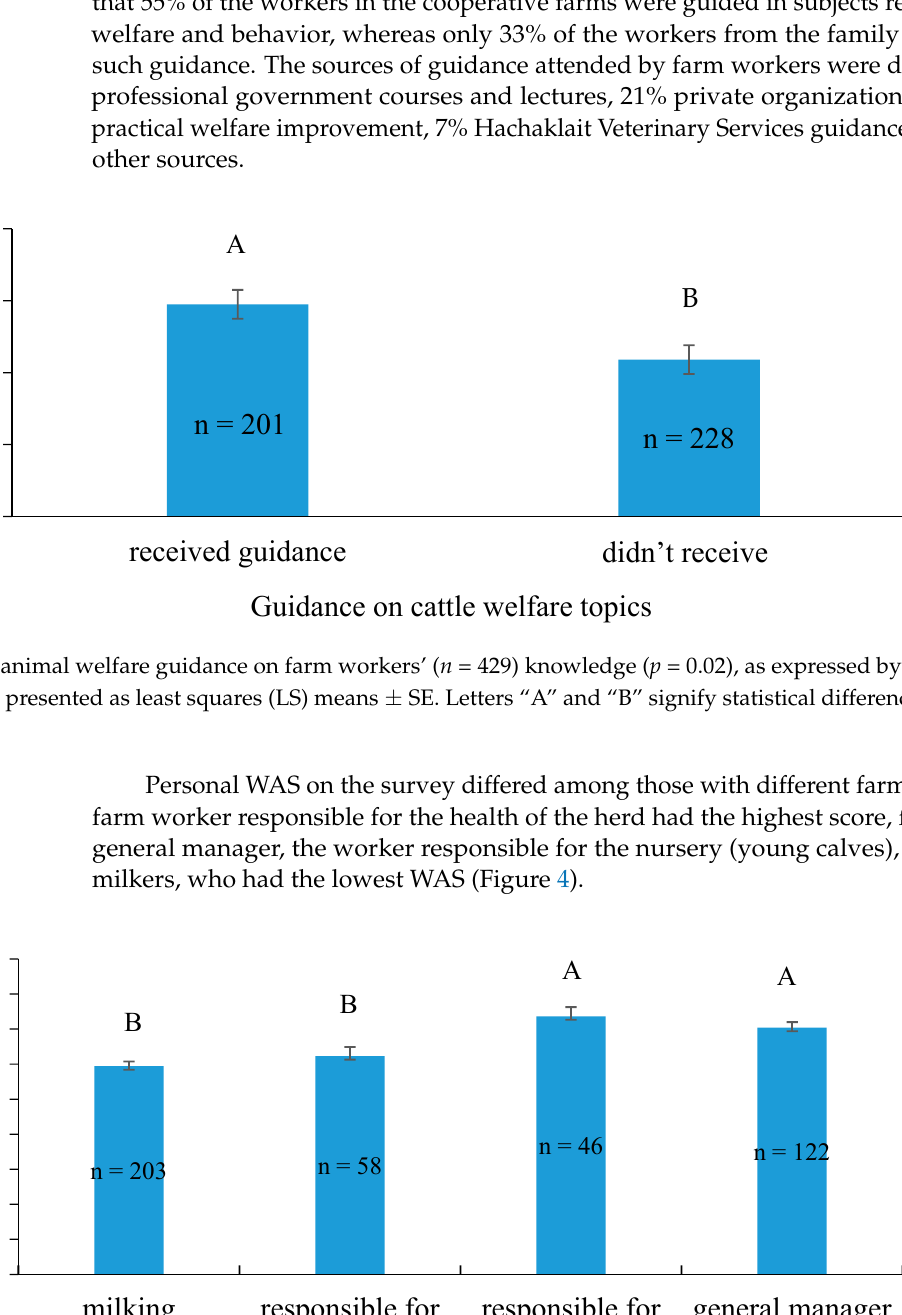
Figure 5. Effect of farm workers’ seniority (years of experience in farming) on their knowledge of animal welfare, as ex ‐ pressed by the welfare assessment score. Values are presented as LS mean ± SE ( n = 429; p < 0.0001). Letters ʺ A ʺ , ʺ B ʺ and ʺ C ʺ signify statistical differences between groups. 3.3. Links between Farm Workers’ Awareness of Welfare and Milk Yield The higher ‐ producing dairy farms had a higher mean FWAS (Figure 6). Farms that scored under 50 on the survey had a mean annual milk yield of 11,167 ± 250 L/cow,